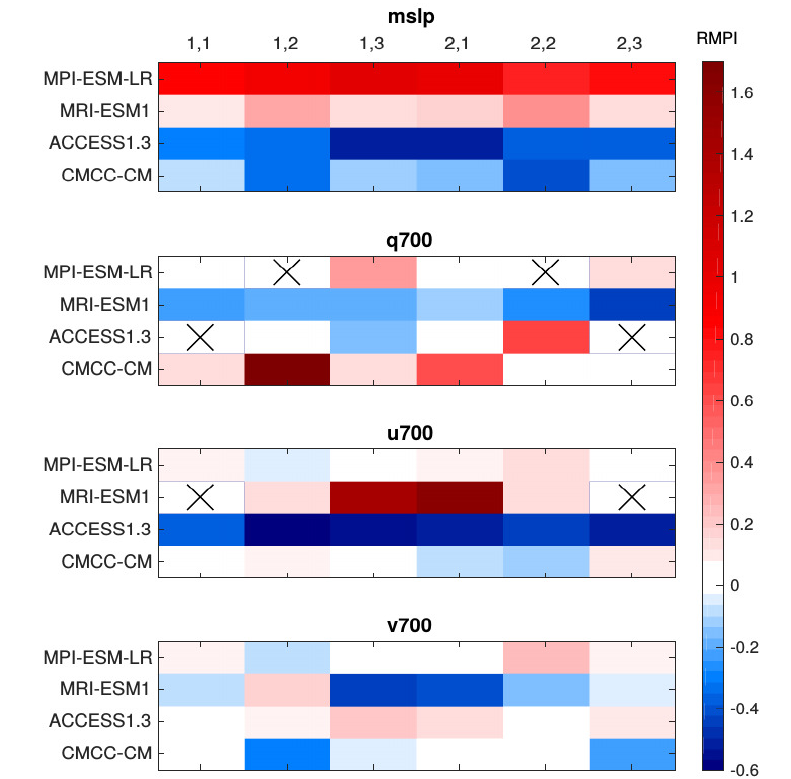
Figure 9. Relative model performance index as a function of weather patterns for mslp, q700, u700, and v700. Weather regimes that were not captured by models are marked with the “ × ” symbol, in accordance with the blank spaces in Tables S2 and S3 of Supplementary